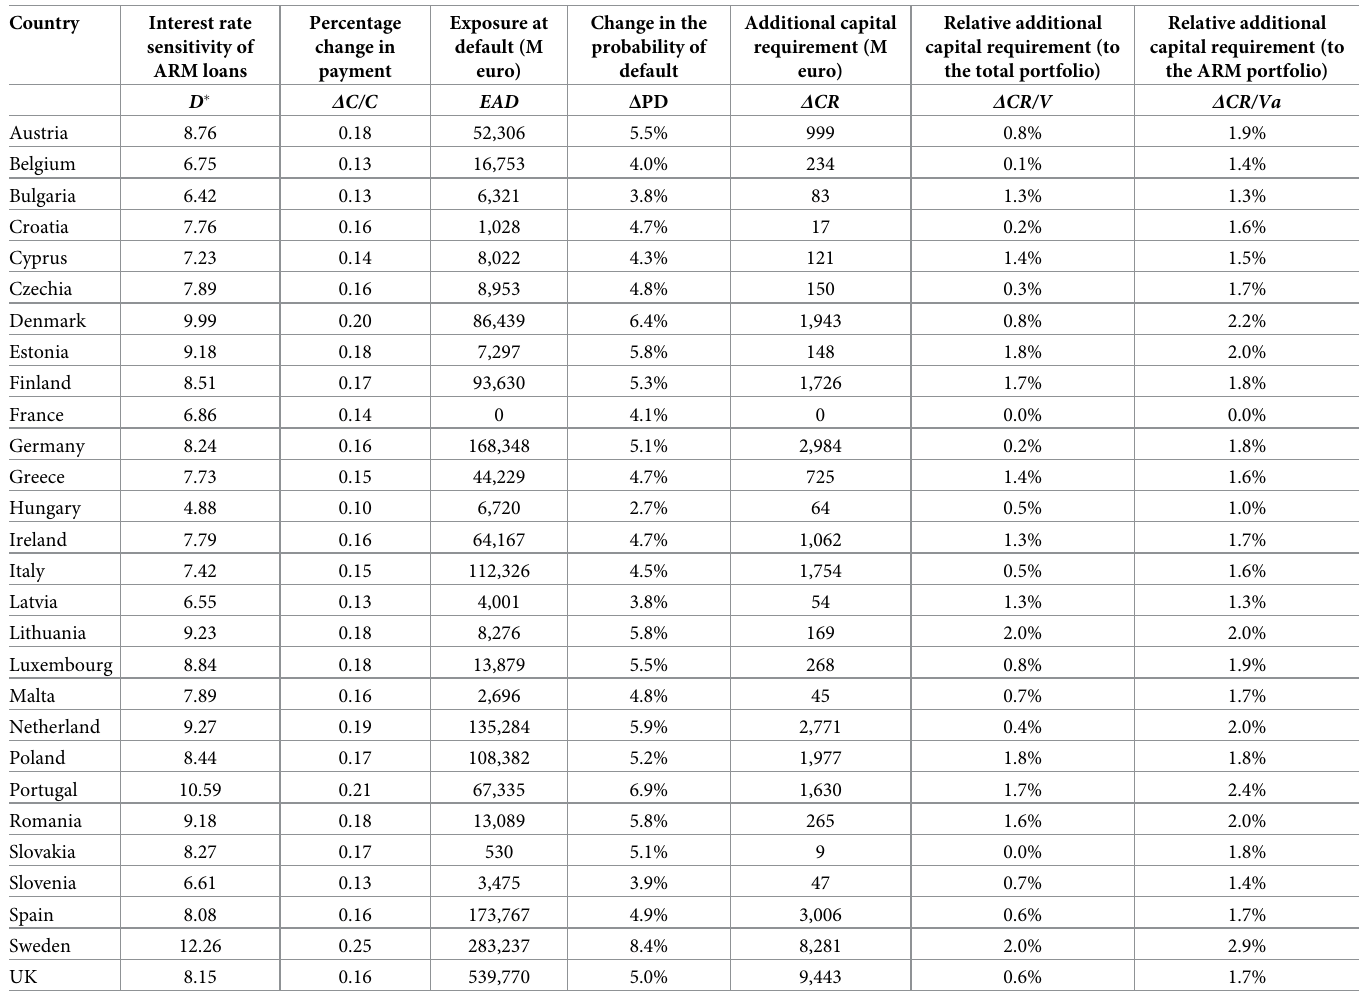
Table 2. Results of stress testing for EU countries (UK included), November 2020.